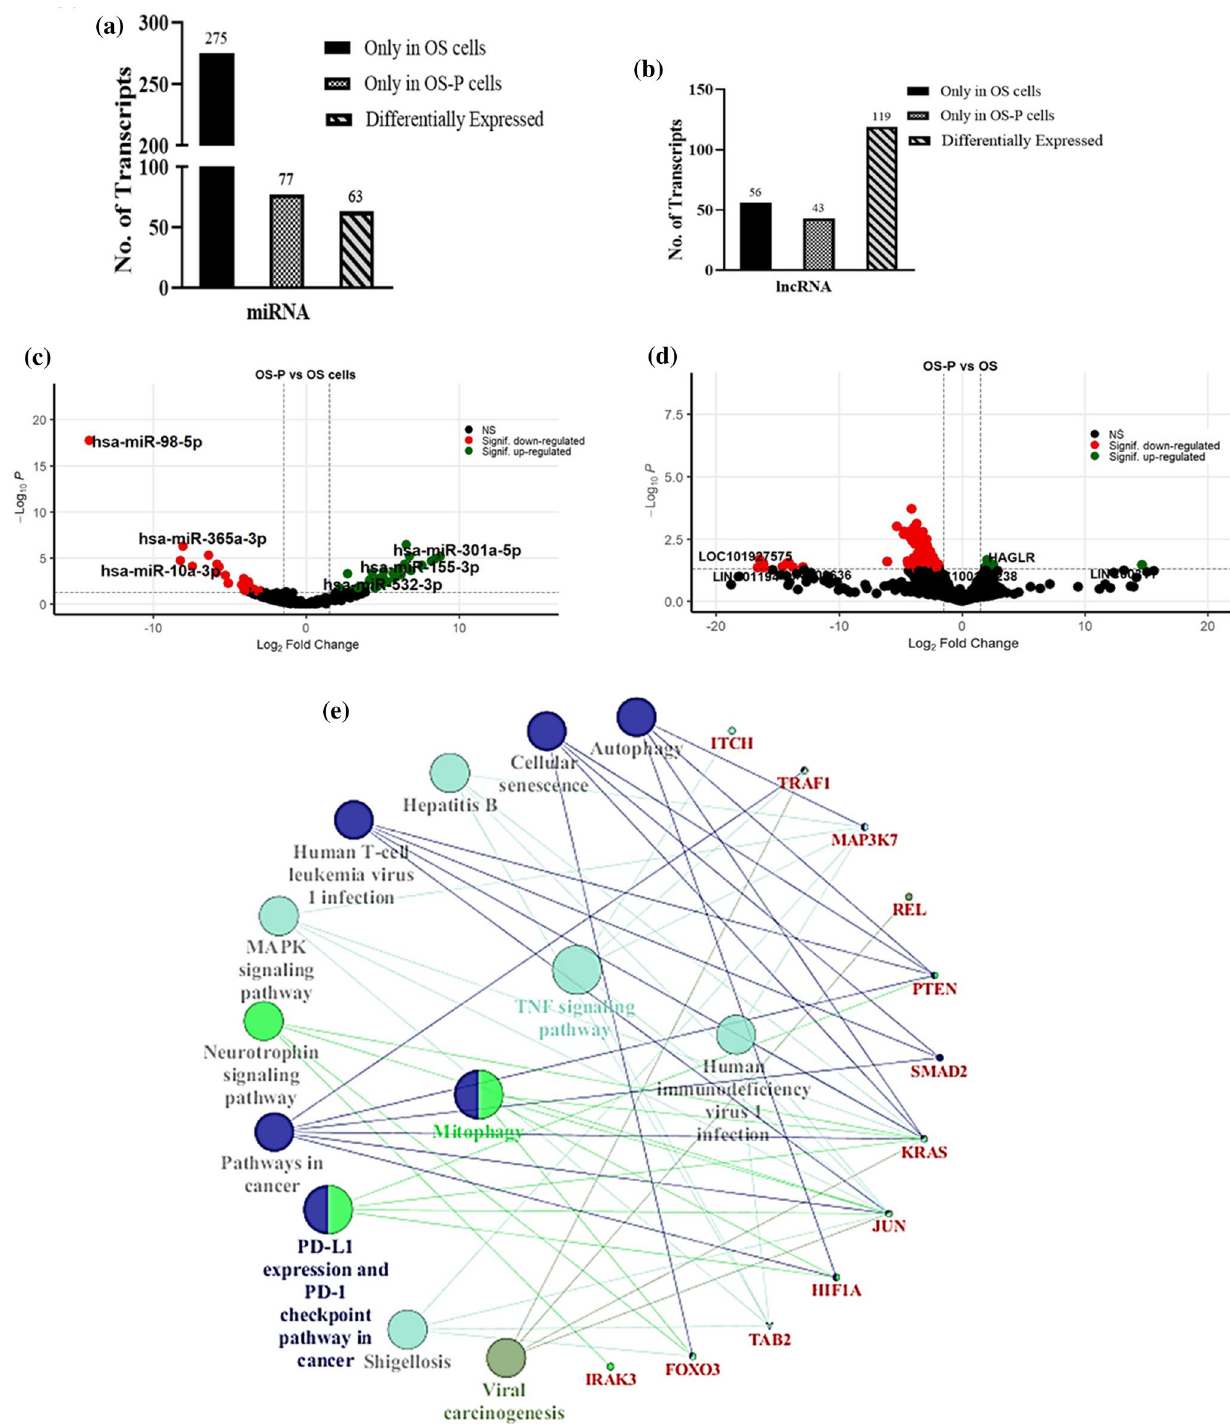
Fig. 2 Comparative transcriptomic analysis of OS-P cells with the untreated control (OS). The bar graph represents the a miRNA transcript and b lncRNA transcript distribution representing the treatment-specific, control-specific and differentially regulated transcripts. In each case, transcripts with a p-value ≤ 0.05 were considered. c , d Volcano plot representing the upregulated (green dots) and downregulated (red dots). c miRNA transcripts and d lncRNA transcripts are shown. The names of the top three up- and downregulated miRNA and lncRNA tran- scripts are mentioned within the plot. Horizontal and vertical dashed lines indicate the significance threshold corresponding to an adjusted p-value of ≤ 0.05 and log2fold change of ± 1.5. e Cytoscape network showing key genes and their pathways regulated by significantly dys- regulated miRNAs in the OS-P vs. OS set. The key red-labeled genes regulated by miRNAs are densely connected with pathways such as TNF signaling, FOXO signaling, and